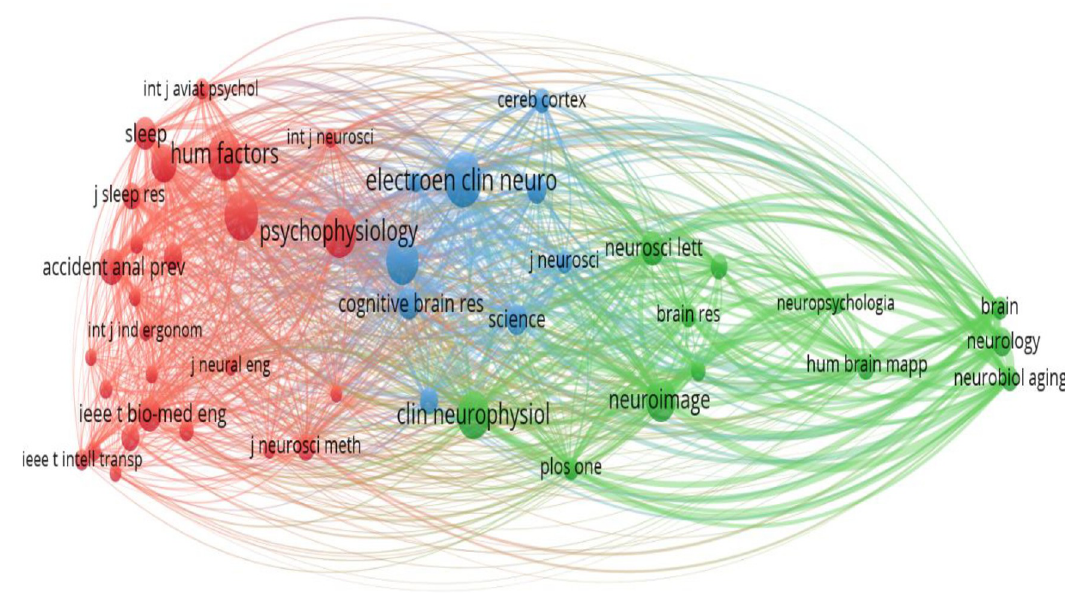
Fig 5. Map of co-citation relationships between publications.